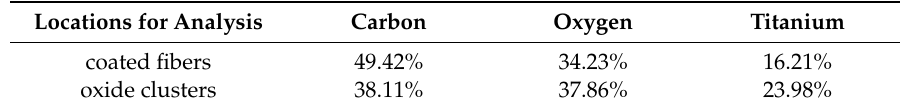
Table 2. Composition analysis statistical results showing the mean of atomic mass content from the energy dispersive X-ray di ff raction spot analysis of 15 samples.